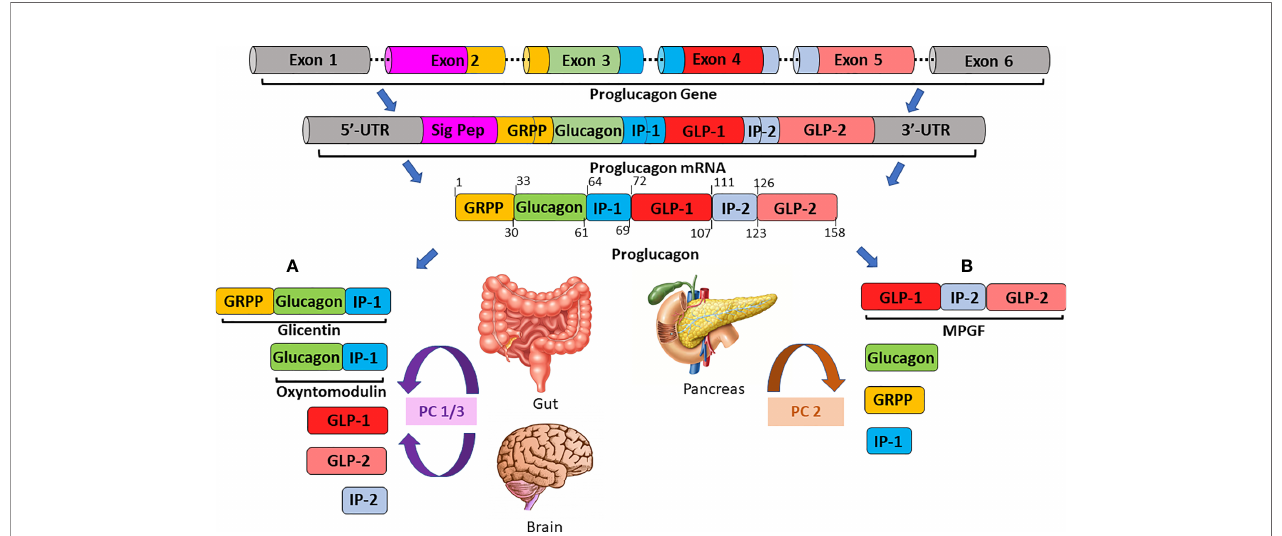
FIGURE 1 | A schematic overview of tissue-speci fi c proglucagon processing in the gut/brain (A) and in the pancreas (B) . The proglucagon gene, located on chromosome 2 and comprised of 6 exons, is transcribed to generate proglucagon messenger RNA (mRNA). Proglucagon mRNA is subsequently translated to yield the 158 residue, precursor protein, proglucagon. In enteroendocrine L-cells of the ileum and colon (A) proglucagon is processed by prohormone convertase 1/3 (PC1/3) to generate glicentin, oxyntomodulin, glucagon-like peptides-1 and -2 (GLP-1, GLP-2) and intervening peptide-2 (IP-2). Conversely, in pancreatic alpha-cells (B) , post-translational modi fi cation by prohormone convertase 2 (PC2) is responsible for the generation of the major proglucagon fragment (MPGF), glucagon, glicentin-related pancreatic polypeptide (GRPP) and intervening peptide-1